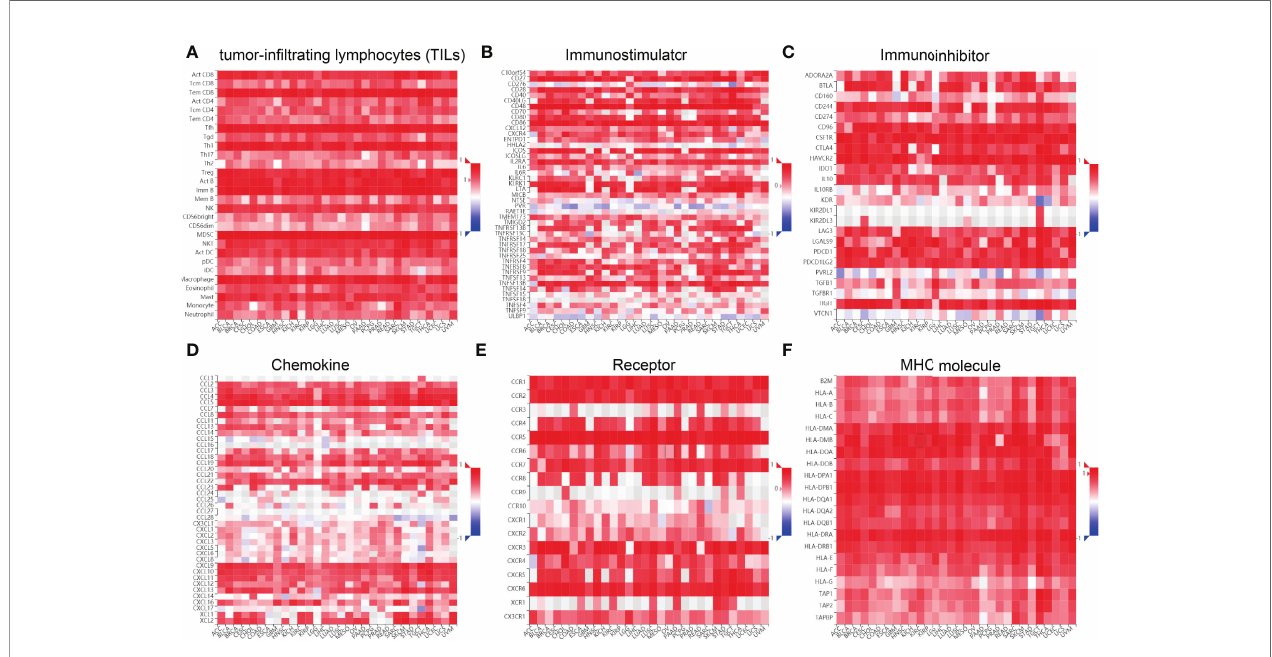
FIGURE 11 | Correlation between SASH3 expression and immune modulators. Expression of SASH3 was signi fi cantly associated with tumor-in fi ltrating lymphocytes (A) , immune inhibitors (B) , immunostimulators (C) , chemokines (D) , receptors (E) , and MHCs (F) .